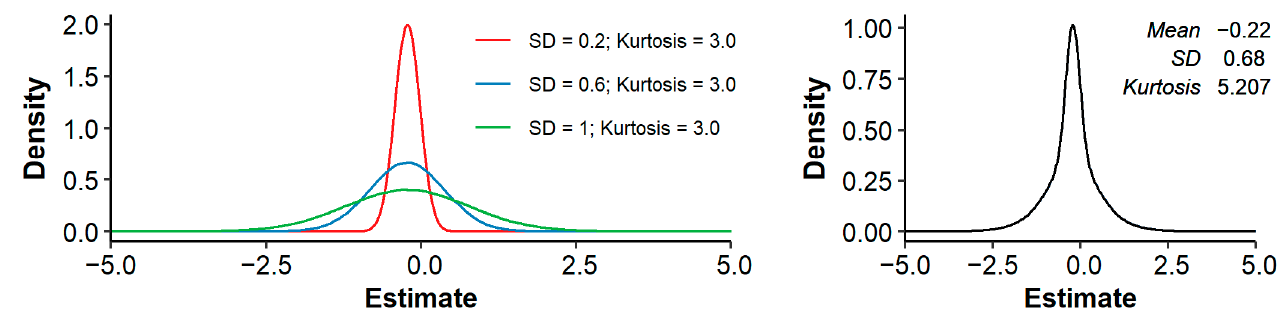
Figure 5. Example with three normal distributions (left; each with a mean of − 0.22 and a SD of 0.2, 0.6 or 1) and the resulting